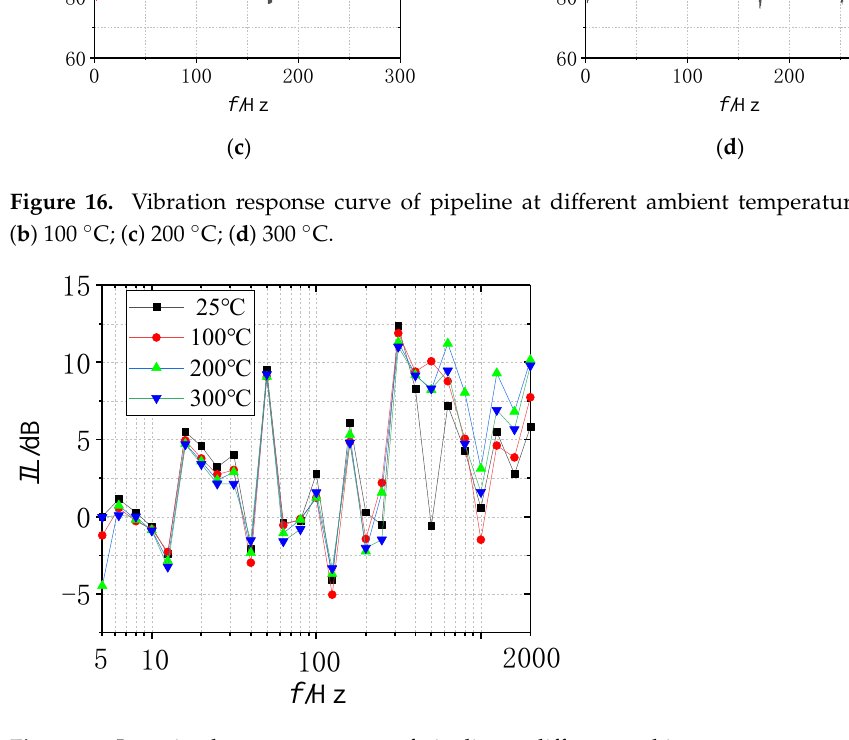
Table 4. Insertion loss ( IL ) of pipeline with LCDS at different ambient temperatures (unit: dB).